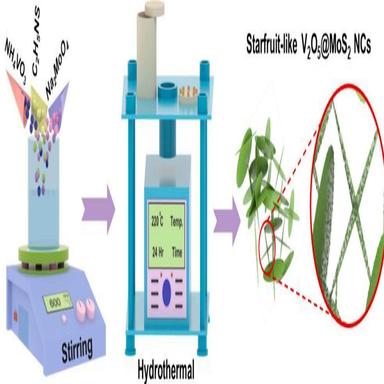
Schematic representation for the fabrication process of V2O5@MoS2 NCs material.